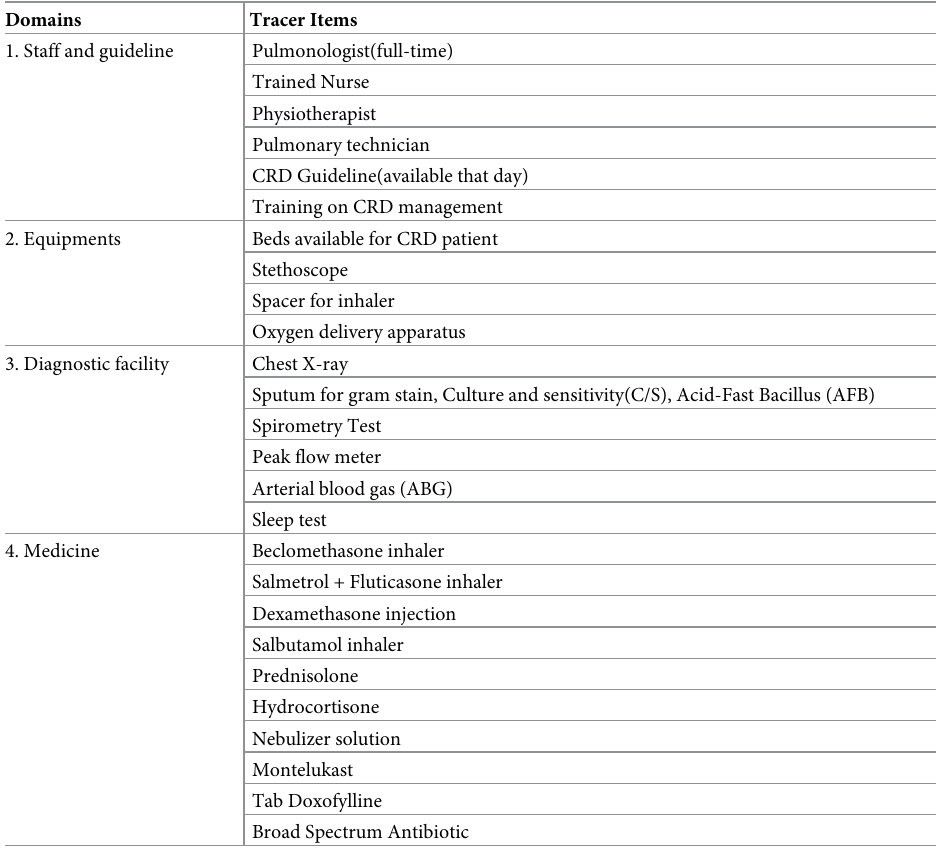
Table 1. Tracer items in respective domains for CRD